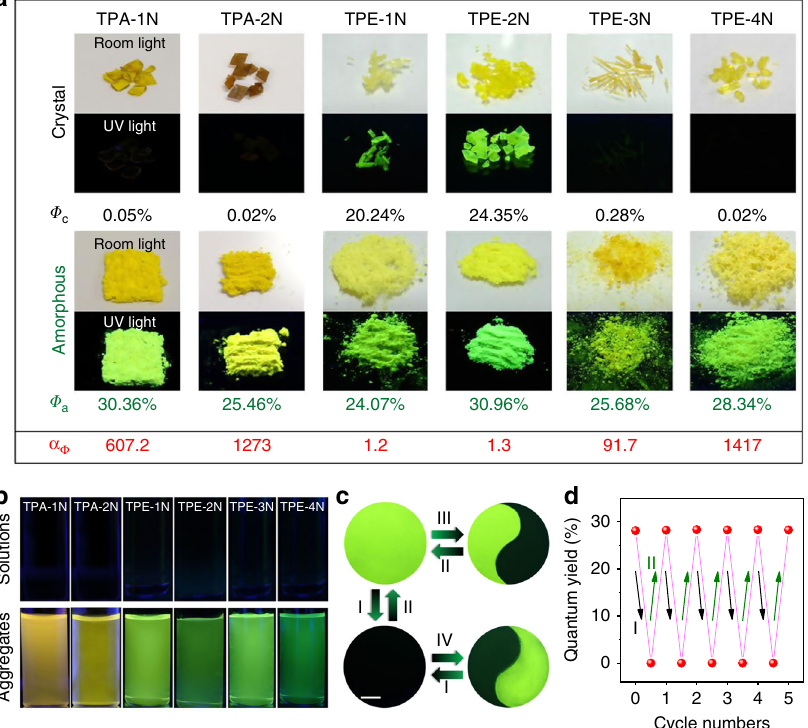
Fig. 2 Photophysical properties of designed MRL molecules. a Photos of luminogens in crystalline and amorphous states taken under room and UV light irradiation with their quantum yields ( Φ ). Luminescence contrast ratio: α Ф = Φ a / Φ c . b Fluorescent photos of luminogens in acetonitrile and acetonitrile/ water mixtures taken under UV light irradiation, luminogens concentration: 1 × 10 − 5 M. c Switching the luminescence of TPE-4N fi lm deposited on a weighing paper through different processes: I, heating at 150 °C or fuming with acetone for 10 s; II, grinding with a glass rod; III, heating with a paper mask for 30 s; IV, grinding with a paper mask. All fl uorescent photos were taken under UV irradiation at 365 nm. Scale = 2 cm. d Plot of luminescence quantum yields versus repeated grinding and heating